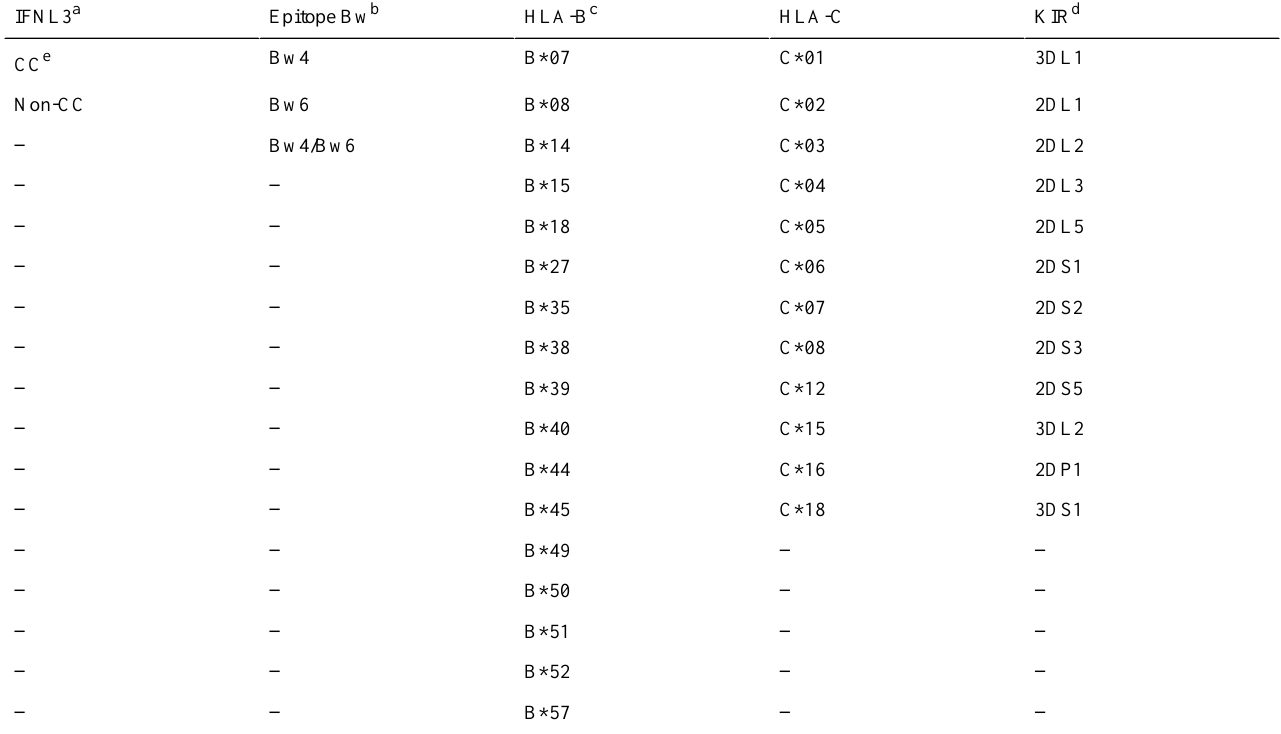
Table 1. Features of each